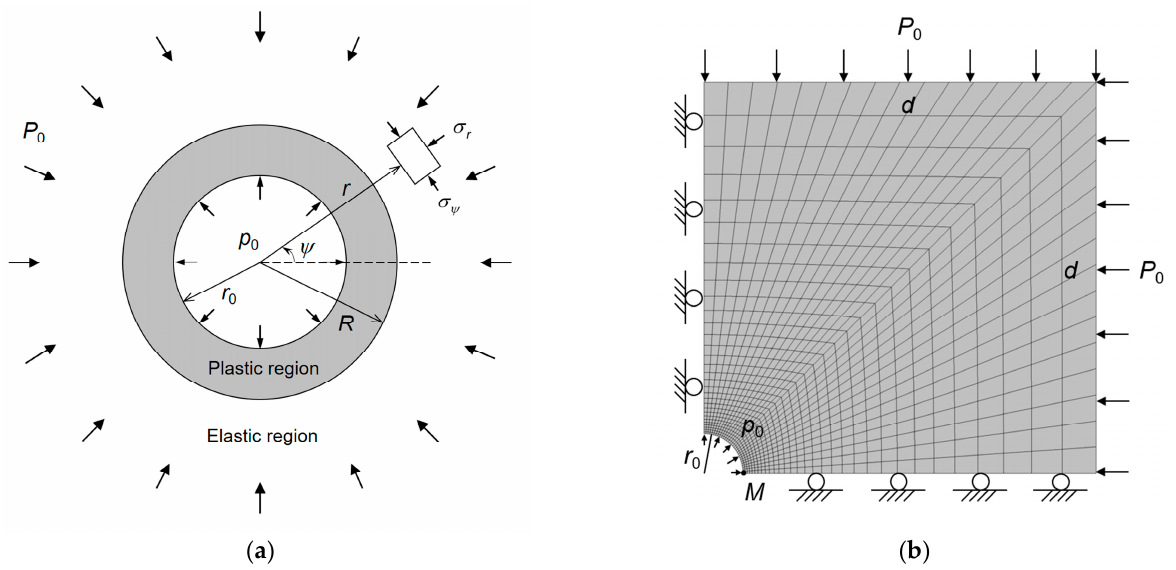
Table 1. Parameters used for comparing the results obtained with the FLAC3D MSDP u ‐ EPP model and analytical solutions (taken from Li and Aubertin [37]).